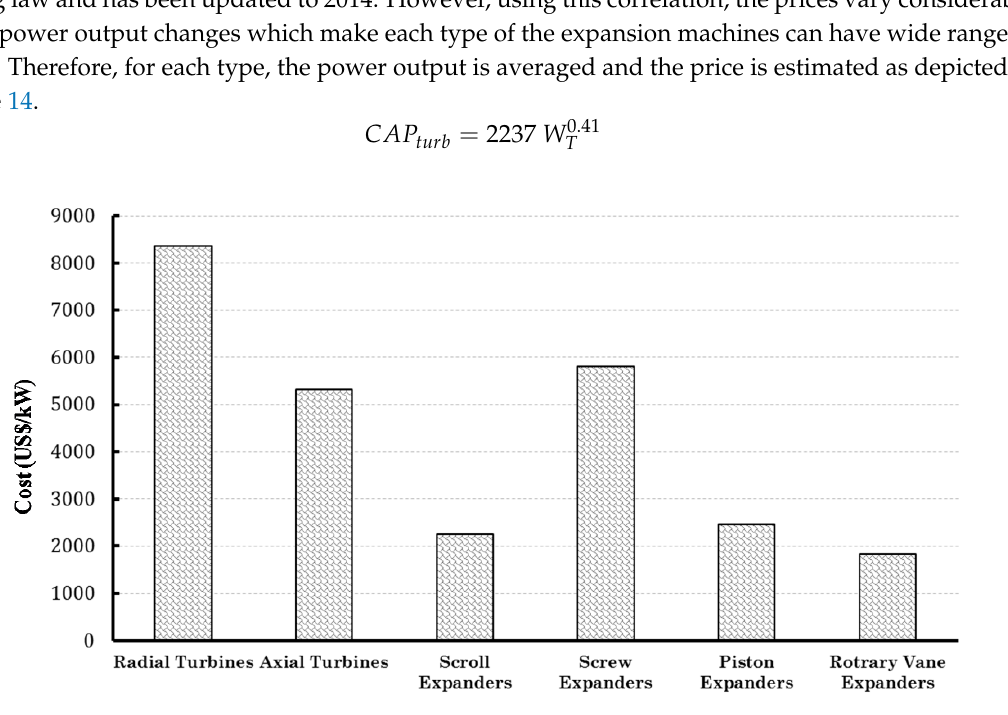
Figure 13. Expander power vs. specific speed for different expanders.